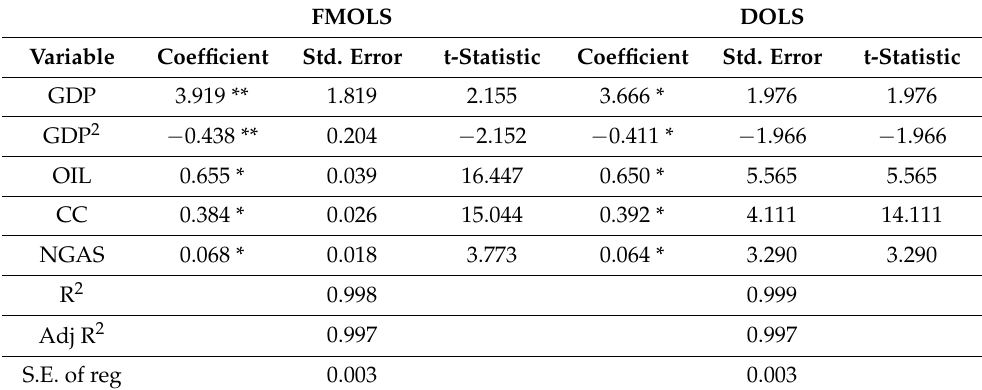
Table 6. FMOLS and DOLS estimation outcome.